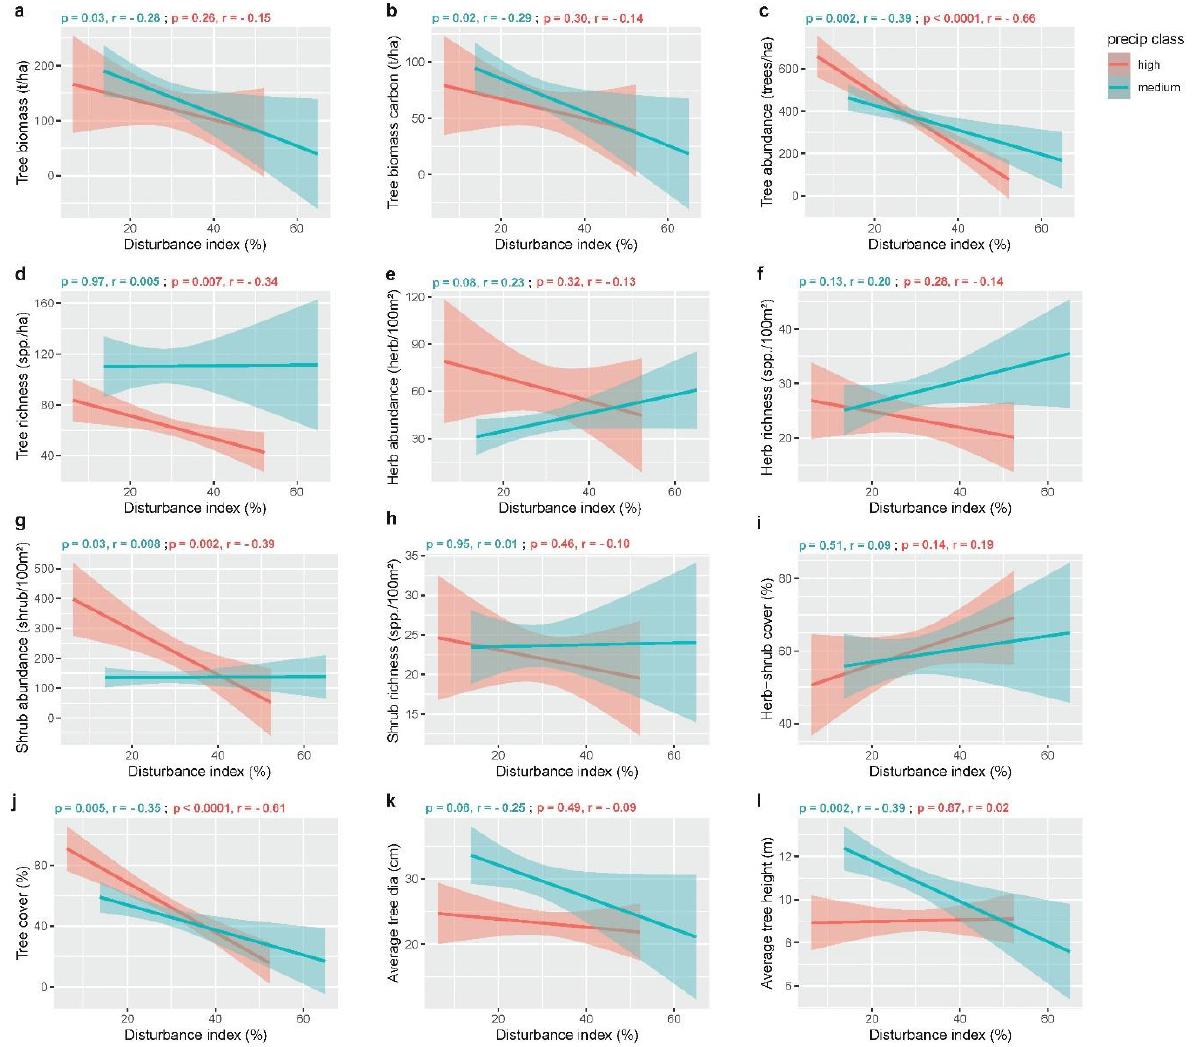
Figure 2. Relationships between disturbance and aboveground ecosystem services under high- and medium-rainfall regimes in our study sites in Northeast Bangladesh.